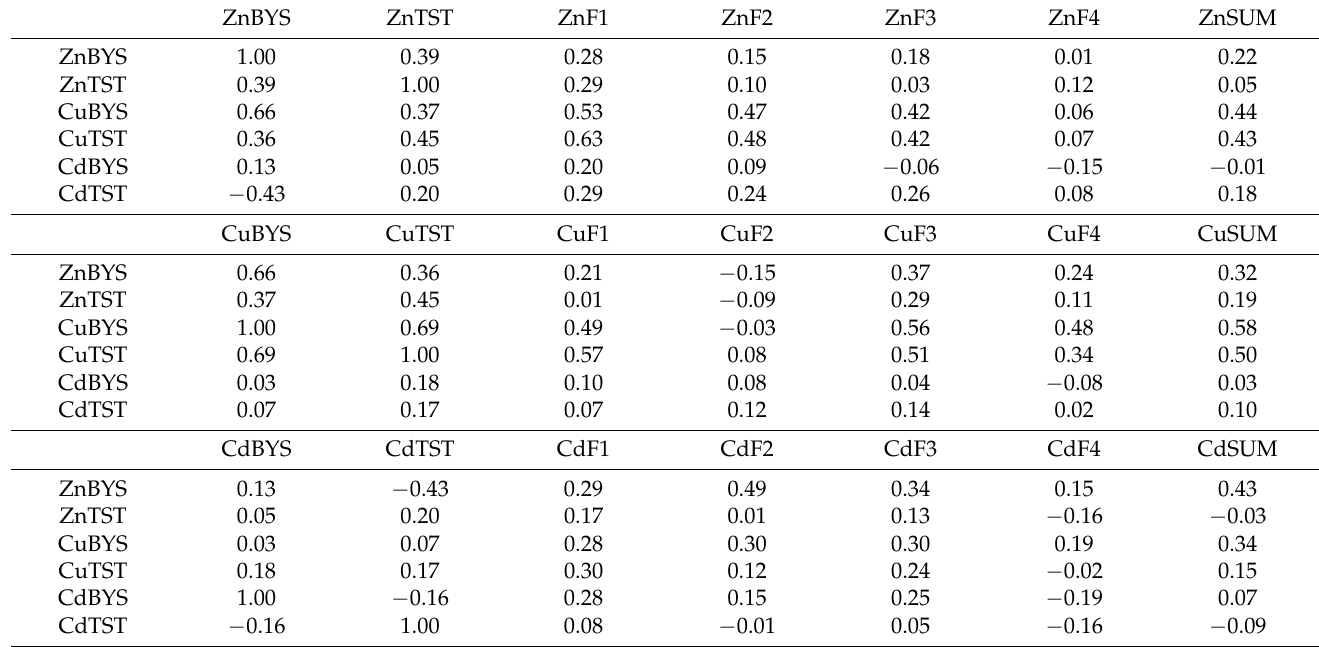
Table 4. Correlation coefficients of metals (Cd, Cu, and Zn) between byssus (BYS) and total soft tissue (TST) of Perna viridis and their geochemical fractions in the surface sediments collected from 34 populations in the coastal waters of Peninsular Malaysia. N =